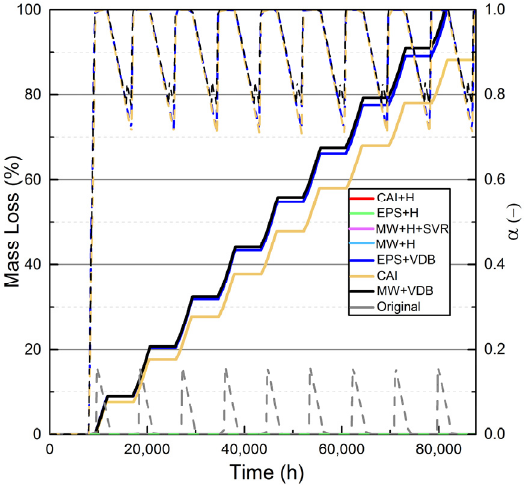
Figure 12. Decay development and fungi activation process during the simulation period based on the Viitanen model.